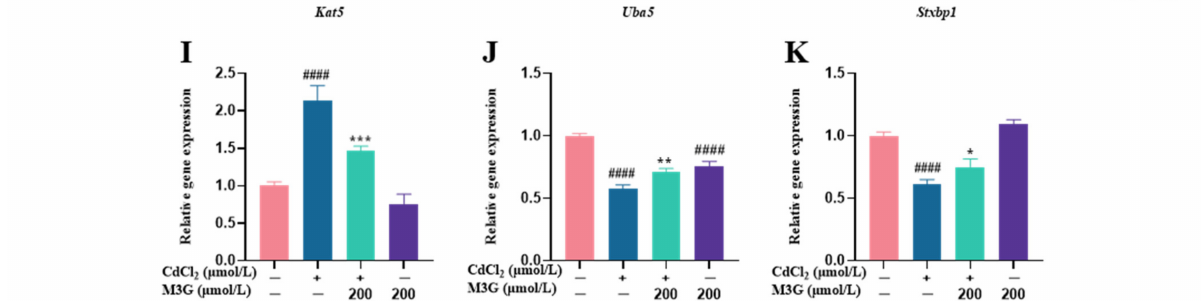
Figure 6. M3G ameliorated the abnormal expression of estrogen-sensitive genes caused by CdCl 2 exposure to KGN cells. Gene expression of KGN cells after treatment with 10 µ mol/L CdCl 2 and 200 µ mol/L M3G alone or in combination. Gene expression of ( A ) Vps18 , ( B ) Vps11 , ( C ) Tiparp , ( D ) Cnot9 , ( E ) Wbp2 , ( F ) Rara , ( G ) Il4r , ( H ) Gba , ( I ) Kat5 , ( J ) Uba5 , and ( K ) Stxbp1 . Mean ± SD, n = 3. # p < 0.05, ### p < 0.001, #### p < 0.0001, vs. control; * p < 0.05, ** p < 0.01, *** p < 0.001, **** p <0.0001, vs. CdCl 2 -treated group.